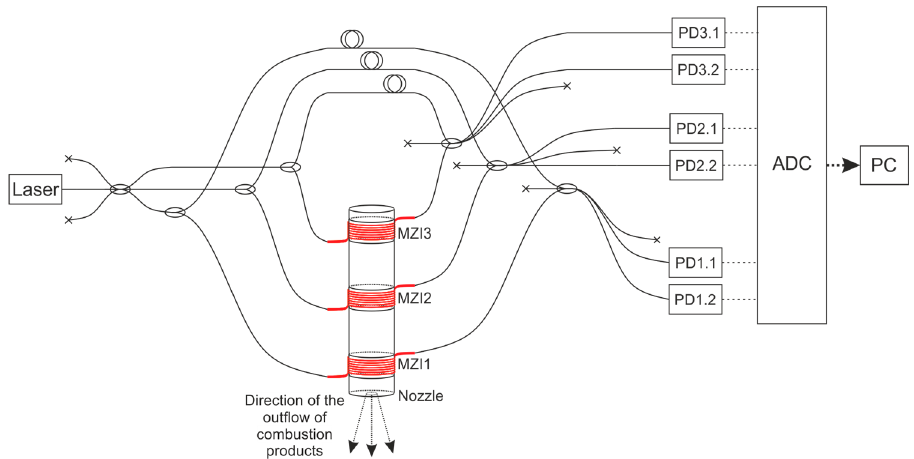
Figure 4. Scheme of the experimental setup. Laser: radiation source; PD: photodiode; ADC: analog-digital converter (L-Card Е 20-10); PC: personal computer.